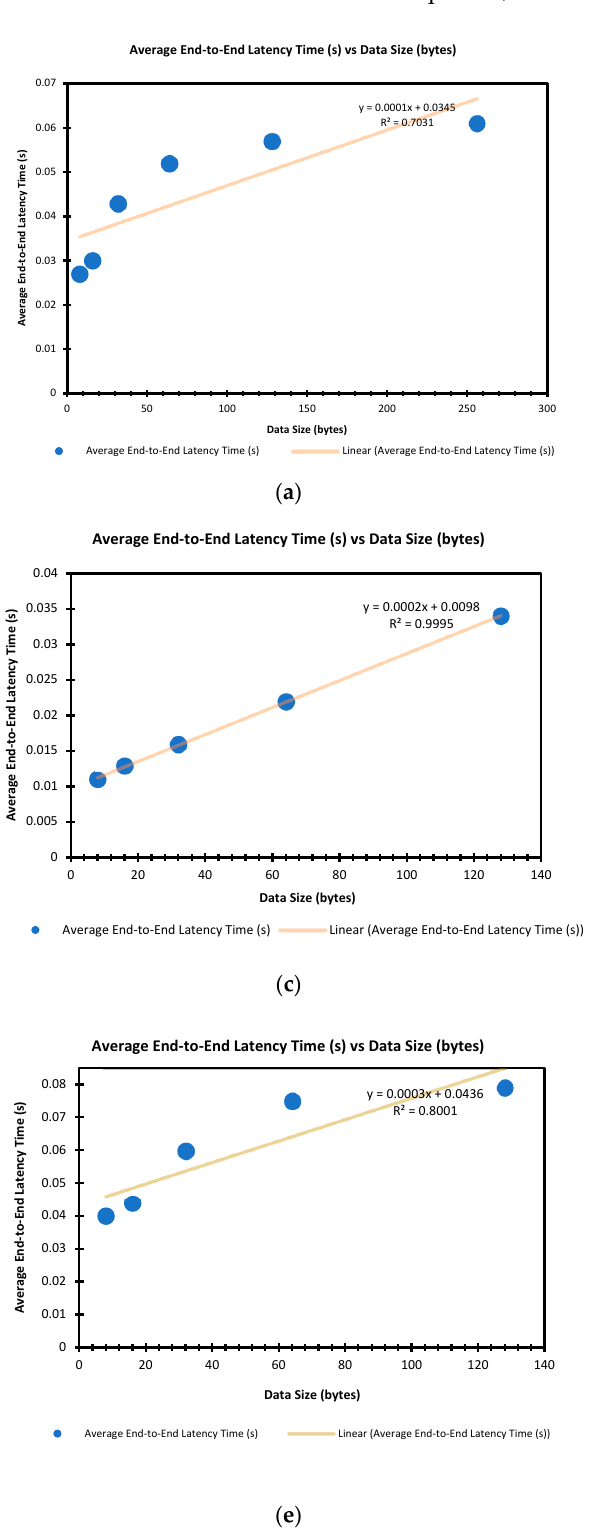
latency versus data packet sizes. Figure 18 shows the graphs of average end-to-end latency time against data size, a combination of all graphs and their respective regression lines derived is then shown in Figure 19. Note that, in the below tables (Table 3), some results could not be captured, because they fell below 0.001 ms.